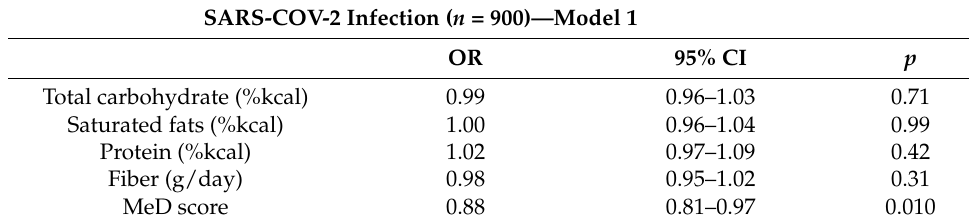
Table 4. Association between SARS-COV-2 infection and adherence to the MeD by logistic regression